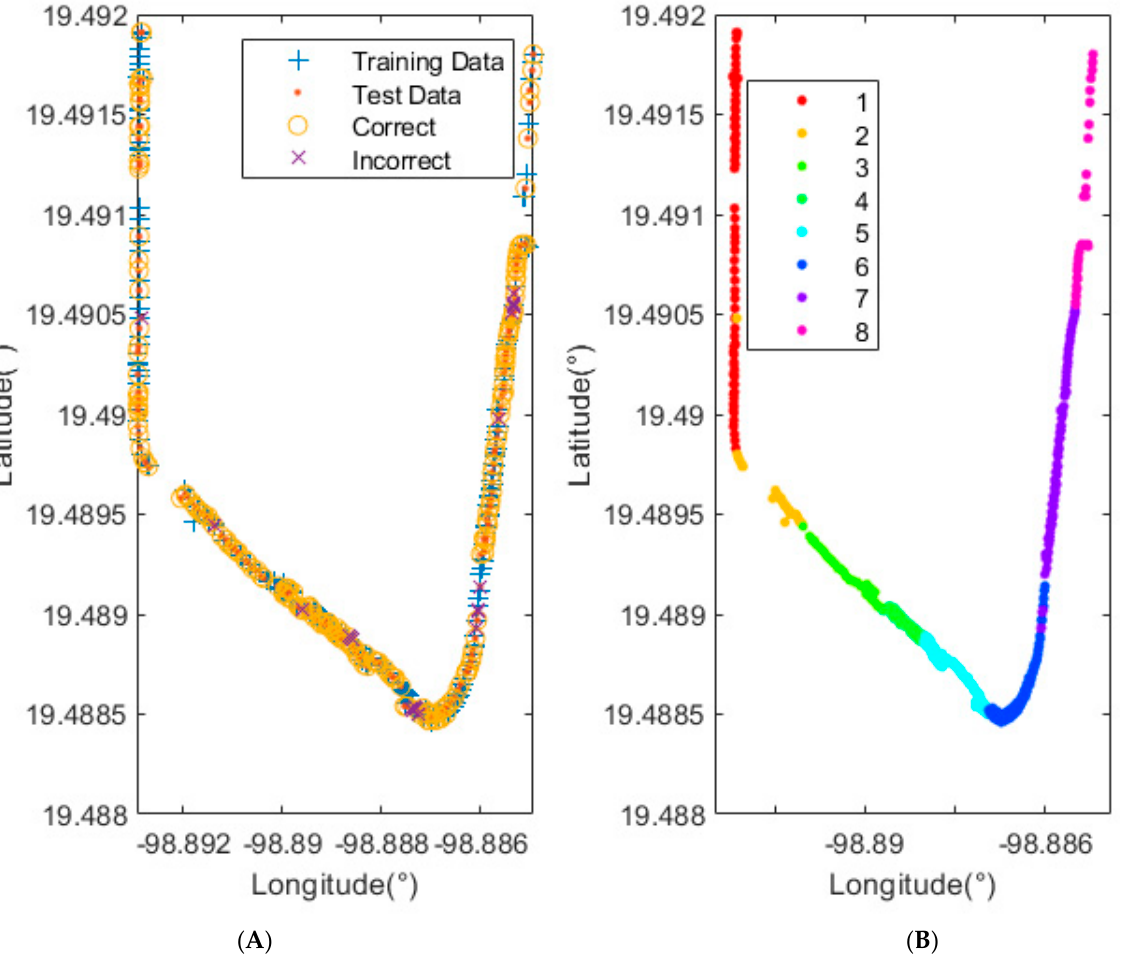
Figure 8. ( A ). Split date test and train each independent data, accuracy = 88.92%. ( B ). Graph all data and class. Table 3. Comparison of techniques against the percentage of data testing.